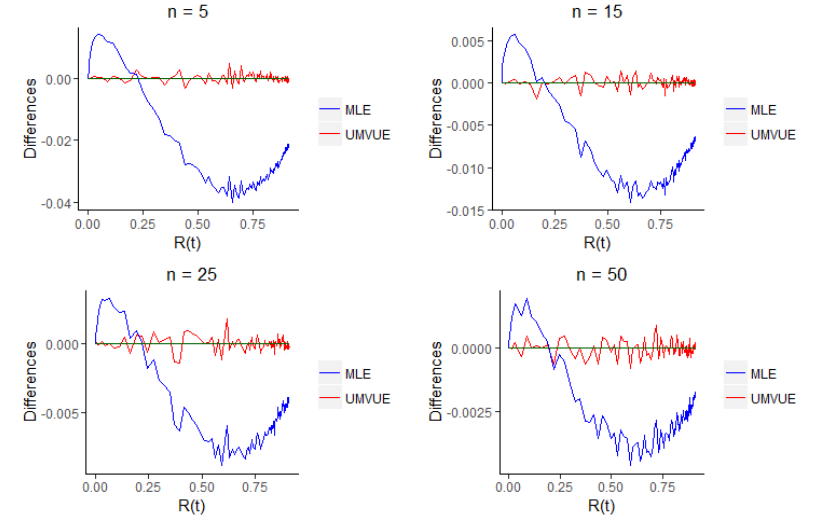
Figure 4 – Estimated bias of the UMVUE and MLE of R ( t ) for different sample